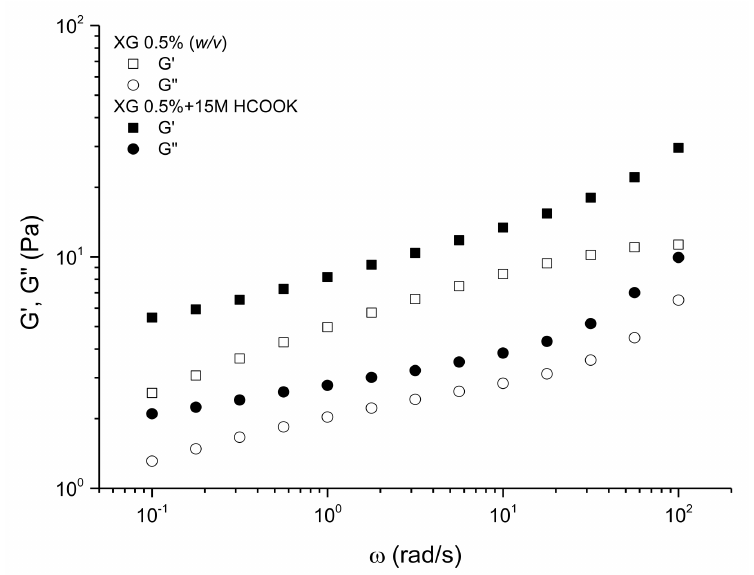
Figure 1. Storage and loss moduli versus the frequency for fresh XG solutions at 0.5% ( w/v ).